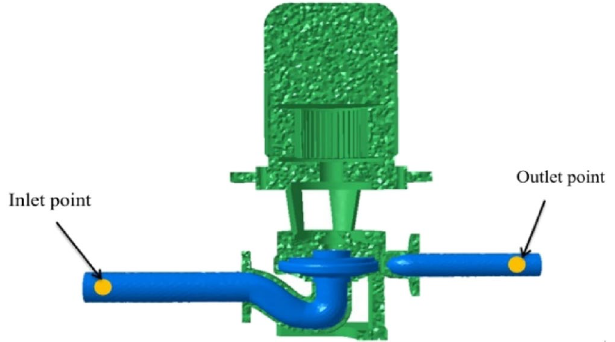
Figure 3. Acoustic-vibration model and monitoring points.